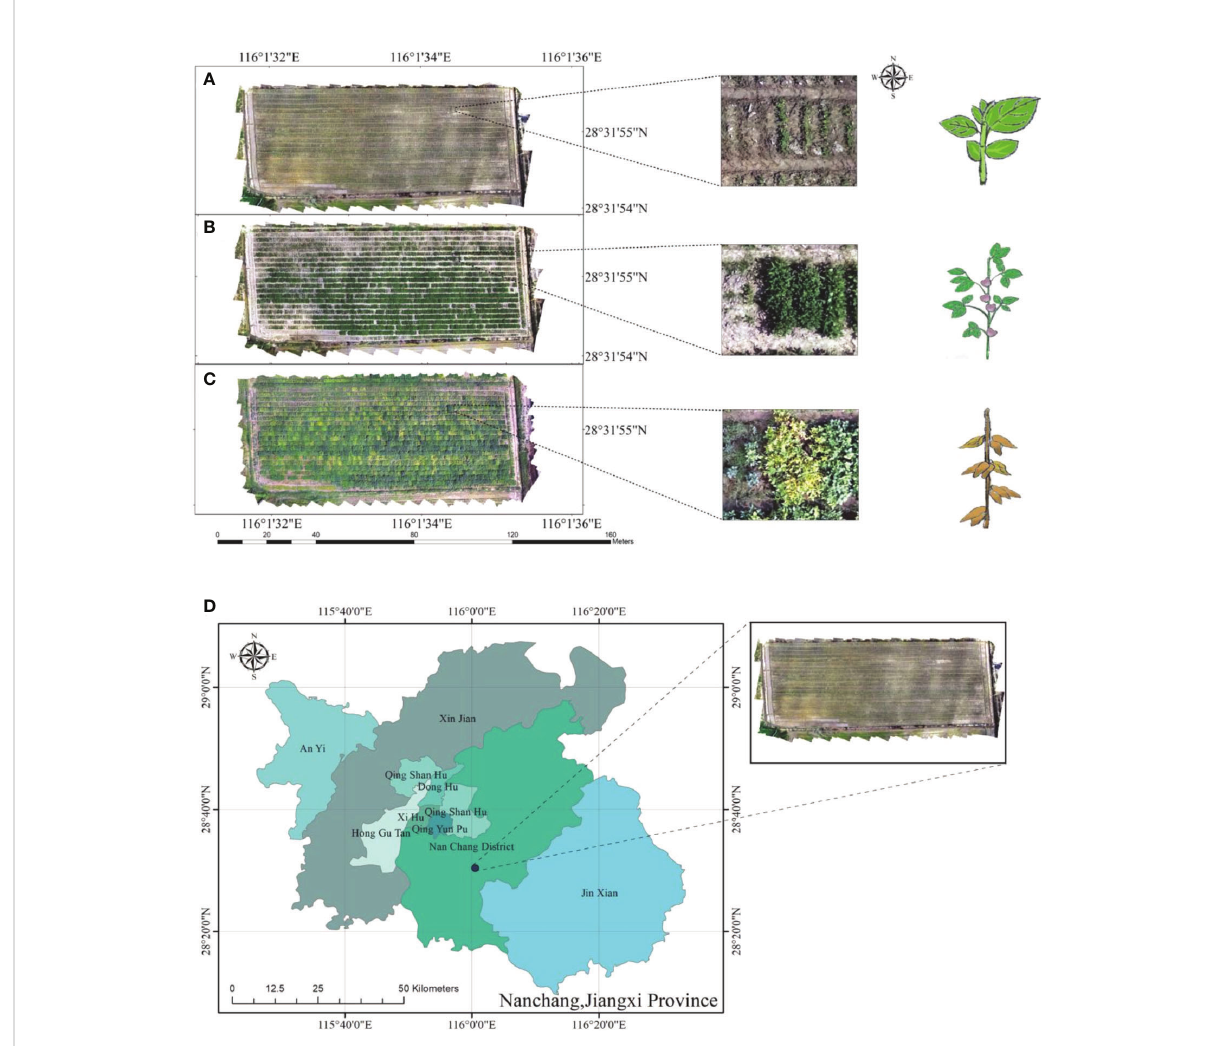
Figure 3A. The mean value was calculated after 10~15 plants were randomly selected in each plot after harvest. The lodgings were monitored by experts from the Jiangxi Academy of Agricultural Sciences (Nanchang, China) to ensure reliable data during the whole growth stage. The levels of lodging severity were divided into fi ve classi fi cations (1-5) (Kato et